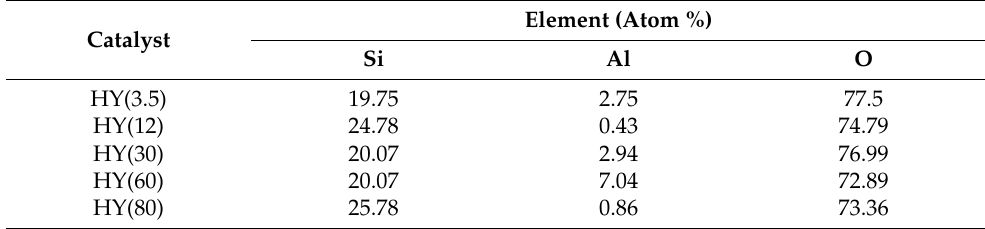
Table A1. Elemental composition of the HY zeolites determined by EDXS.